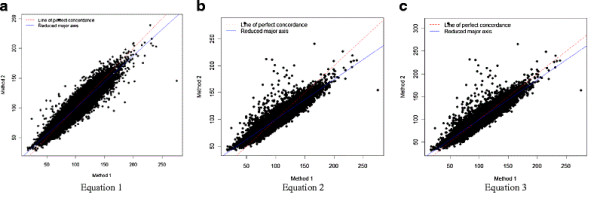
Scatter plot of estimated results by each equation and observed results.